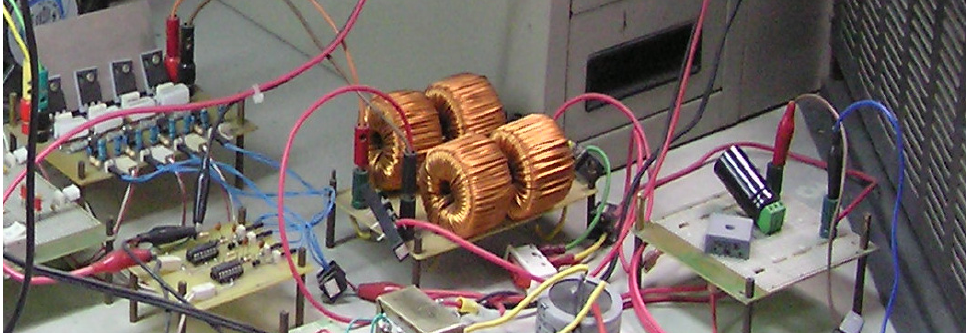
Figure 6. Photograph of the hardware implementation.